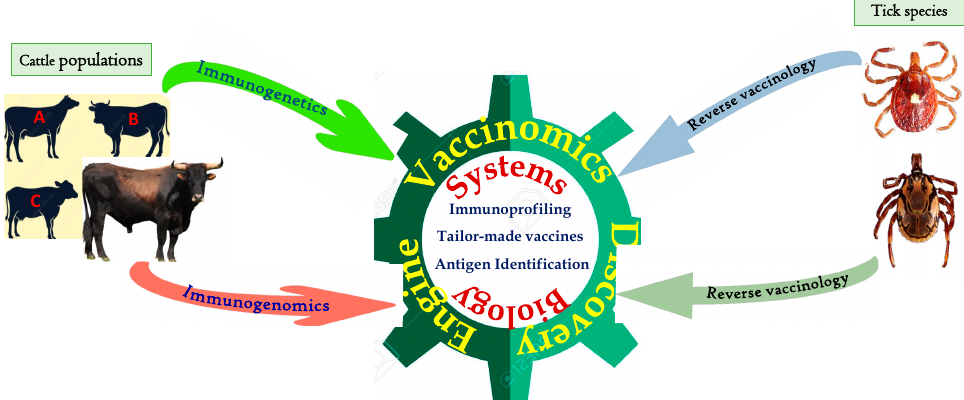
Figure 1. Application of reverse vaccinology to identify anti-tick antigens, and how components of vaccinomics (immunogenetics and immunogenomics) can be integrated with system biology to design cattle population/breed-tailored vaccines against ‘local’ ticks. Letters A, B and C indicate different cattle populations.